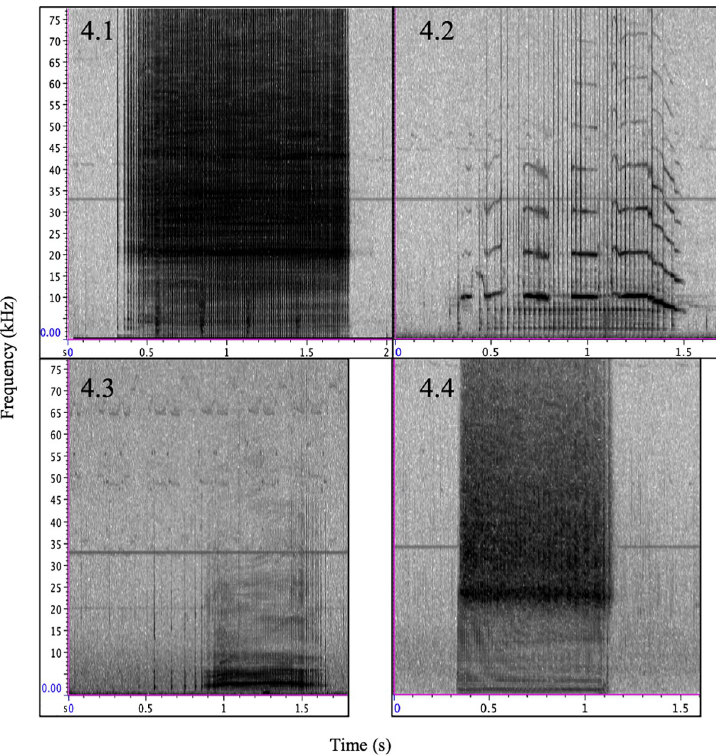
Fig 4. Example comparisons of type E (4.1), C (4.2), F (4.3), and T (4.4.). Spectrogram parameters: DFT size 512, 256 sample hop size, and Hann window 512 samples.